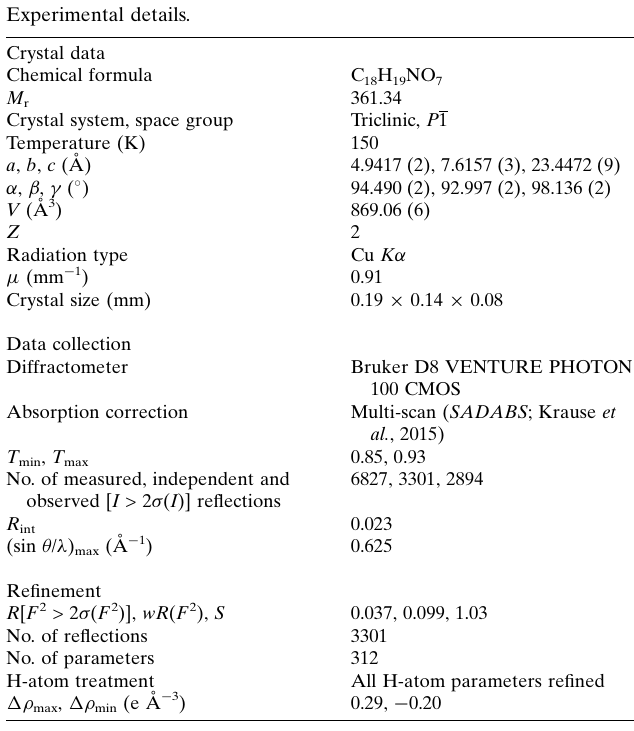
Table 2 Experimental details.